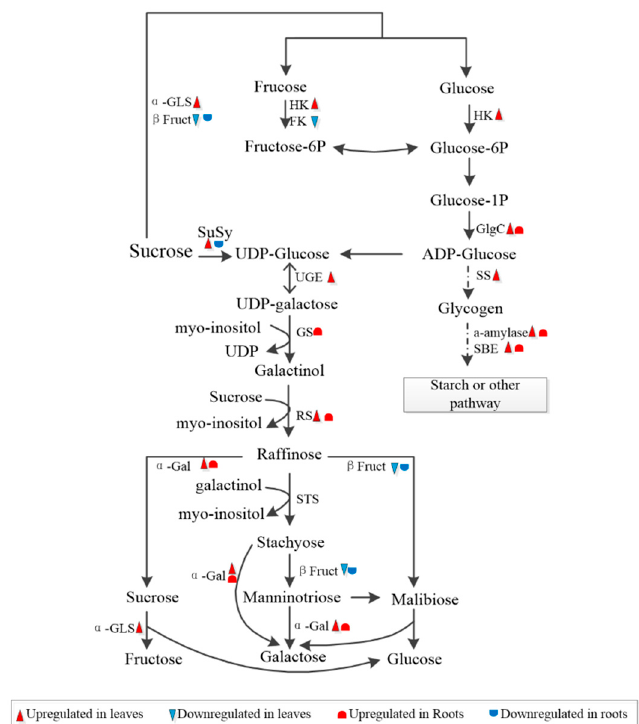
Figure 7. Schematic representation of sugar and glycogen synthesis in mulberry under stress conditions. FK, fructokinase; β Fruct, beta-fructofuranosidase; HK, hexokinase; a-Gal, alpha-galactosidase; GlgC, glucose-1-phosphate adenylyltransferase; a-GLS, alpha-glucosidase; GS, galactinol synthase; RS, raffinose synthase; SBE, 1,4-alpha-glucan branching enzyme; SS, Starch synthase; SuSy, sucrose synthesis; UGE, UDP-glucose 4-epimerase; the upregulated genes are marked in red. (Color figure online). In contrast, another ra ffi nose synthase (Morus020545.p1) and α -galactosidases